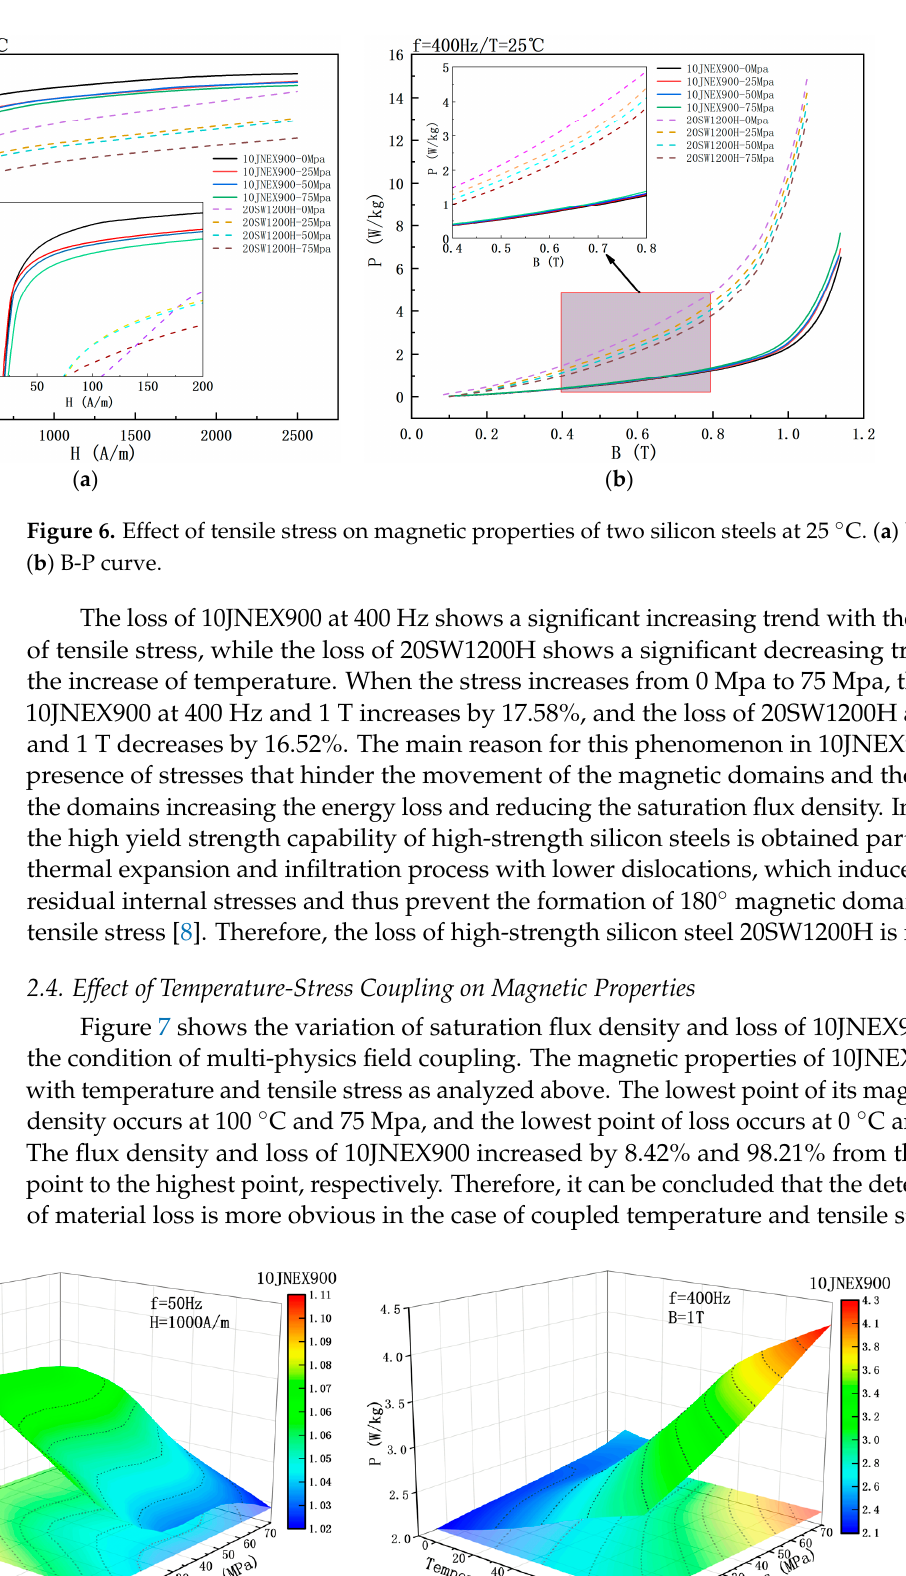
Figure 7. Effect of multi-physical field coupling on the magnetic properties of 10JNEX900. ( a ) Trend of B. ( b ) Trend of